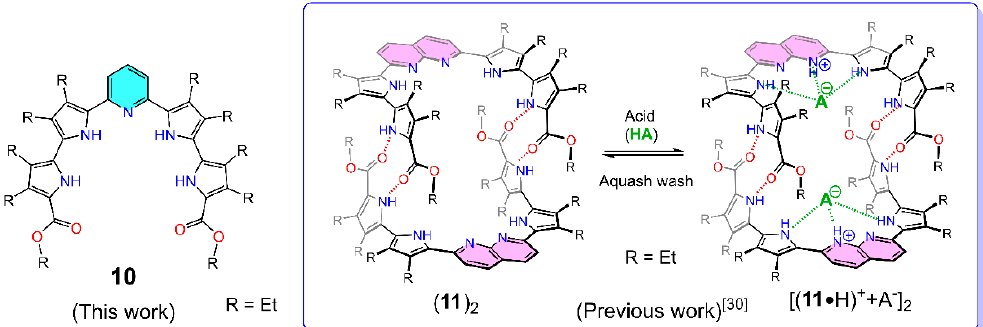
Figure 1. Chemical structures of the oligopyrrole-based receptor 10 used in our present study and receptor 11 used in our earlier study [30]. The pseudo-macrocyclic cage of a rigid dimer ( 11 ) 2 formed via hydrogen-bonding interactions enables acid recognition within its cavity.